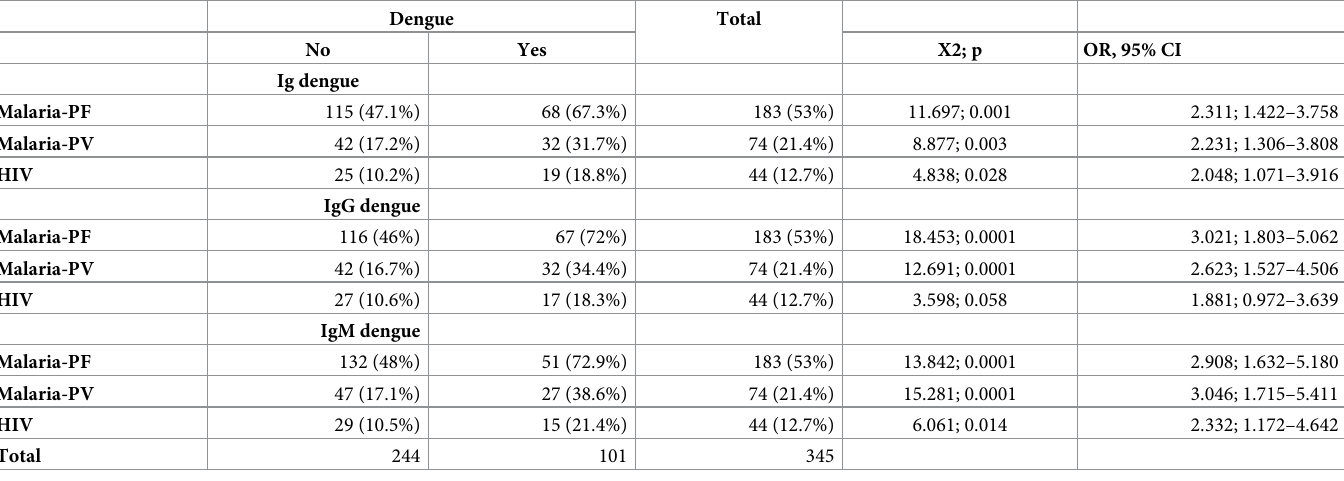
Table 4. Association between dengue (current and past), malaria and